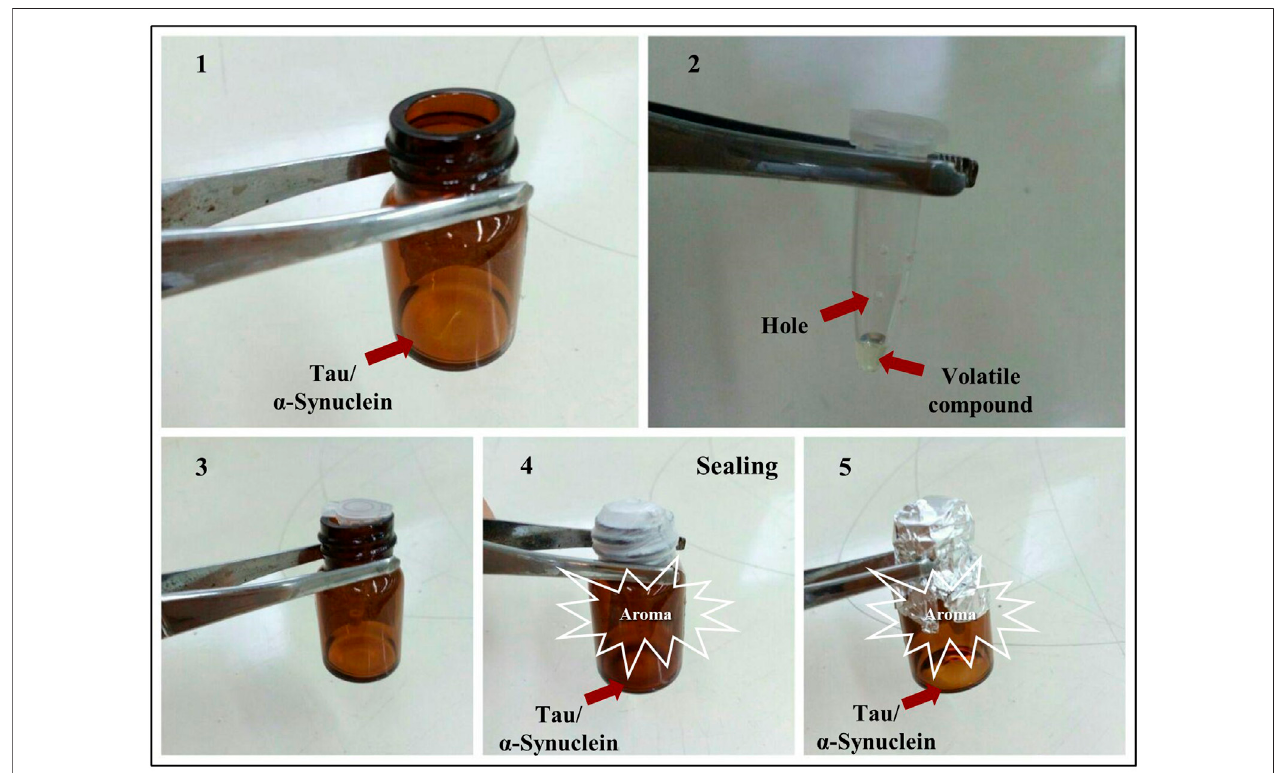
FIGURE 1 | Experimental setup. (1) Tau protein sample solutions were prepared by initially adding 700 µl of a solution containing 20 µM tau protein in 50 mM Tris- HCl of pH 7.6, and 100 mM NaCl in the presence of 5 µM of Heparin and 5 mM DTT. As for α -synuclein, the sample solution contained 1 ml of 142 µM of α -synuclein in PBSofpH7.4.Bothsamplesolutionswereplacedin20 mlbottles.(2)Holesweremadein0.5 mlEppendorftubes,andthen20 μ lofPEA,Cin,orTEMEDwasaddedto the Eppendorf tubes. (3) The Eppendorf tubes with holes were placed inside the bottles. (4,5) The Eppendorf tubes placed inside the 20 ml bottles were sealed together and incubated at 37 ° C for 96 h for tau protein in a shaker at 500 rpm, and at 37 ° C for 72 h in a shaker at 220 rpm for α -synuclein, in order for the process of fi brillation to take place, in the presence of PEA, Cin, or TEMED.